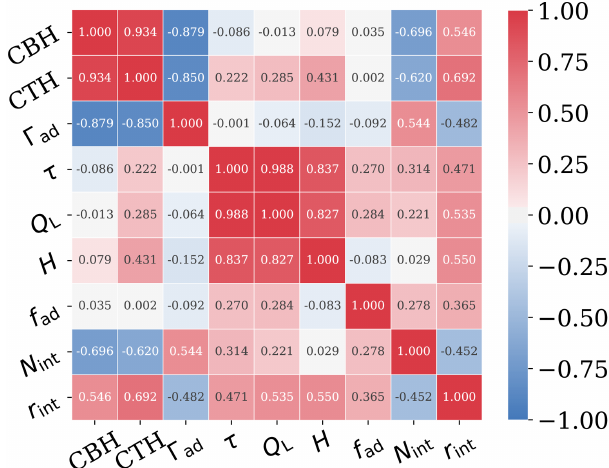
Figure 4. Correlation plot between all the properties (CBH, CTH, (cid:48) ad , τ , Q L , H , f ad , N int , and r int ). The color bar indicates the val- ues of the corresponding Pearson